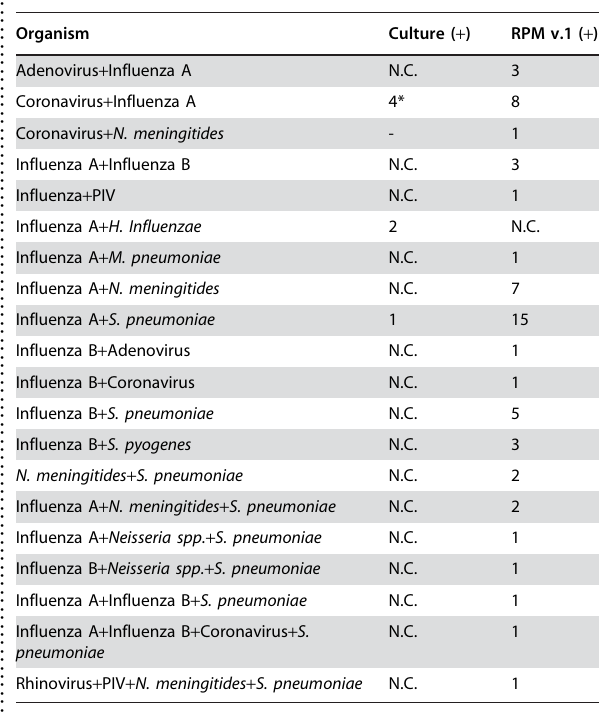
Table 4. Comparative results for specimens positive